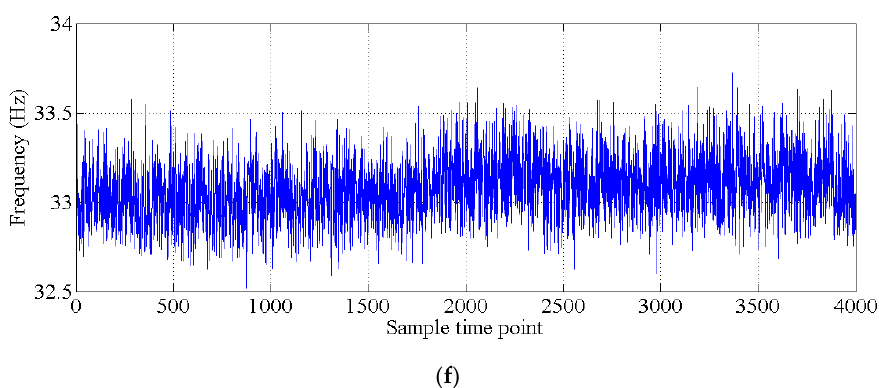
Figure 15. Natural monitoring frequencies: ( a ) mode 1; ( b ) mode 2; ( c ) mode 3; ( d ) mode 4; ( e ) mode 5; ( f ) mode 6.